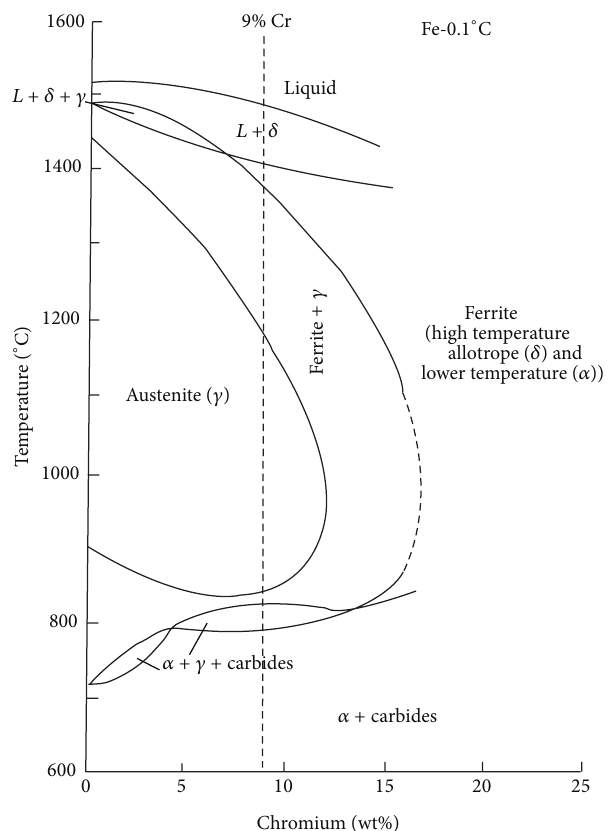
Figure 6: Modified 9Cr-1Mo phase